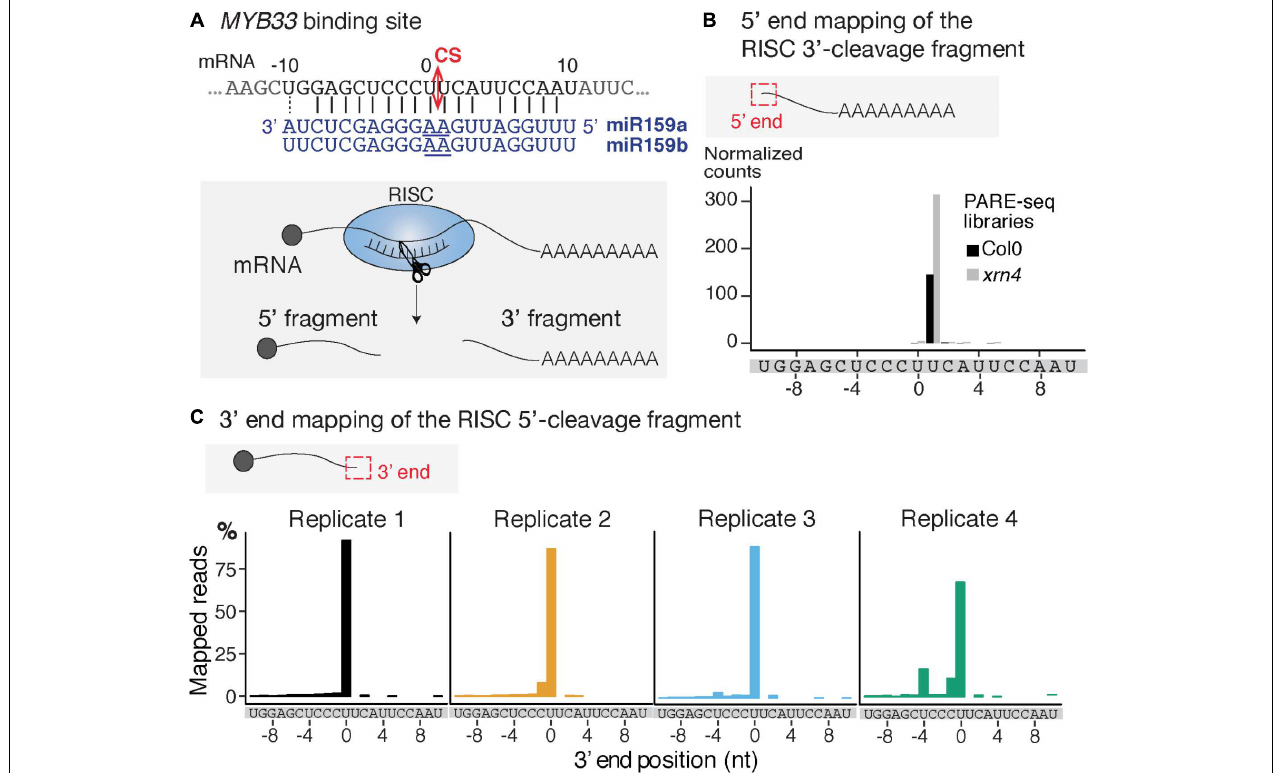
FIGURE 2 | Mapping of the 3 (cid:48) extremity of MYB33 RISC 5 (cid:48) -cleavage fragments. (A) Schematic representation of the cleavage of MYB33 mRNA by AGO1 loaded with miR159. The cleavage site (CS) is predicted between the positions 0 and +1, and is defined by the 10th and 11th nucleotides (underlined) of miR159. (B) 5 (cid:48) end mapping using PARE-seq data (German et al., 2008) of RISC 3 (cid:48) -cleavage fragments in WT and xrn4 . (C) 3 (cid:48) end mapping by 3 (cid:48) RACE-seq of RISC 5 (cid:48) -cleavage fragments in WT within the –10/ + 10 window corresponding to the MYB33 sequence recognized by miR159. For 3 (cid:48) RACE-seq, most reads map to a single position in each of the four WT biological replicates.